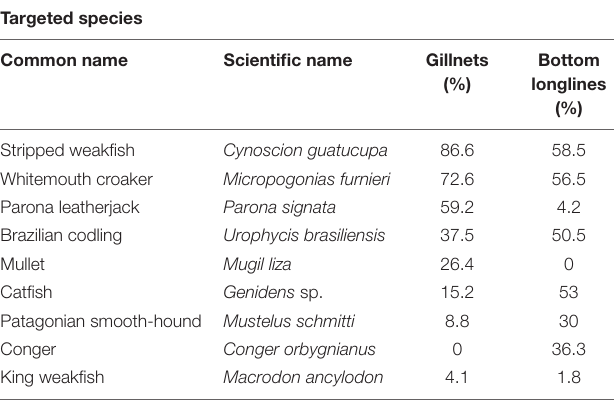
TABLE 3 | Combined species occurrence index (%) showing species most commonly caught by both fishing gear